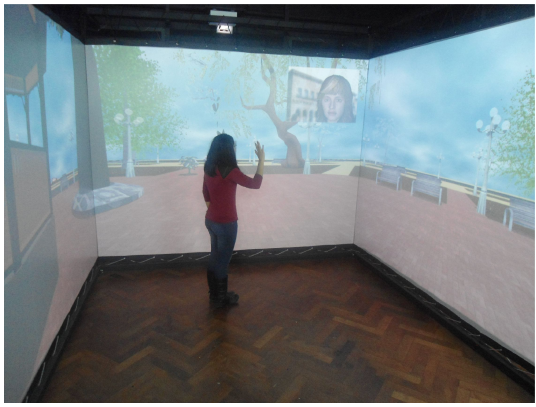
Figure 2. Immersive